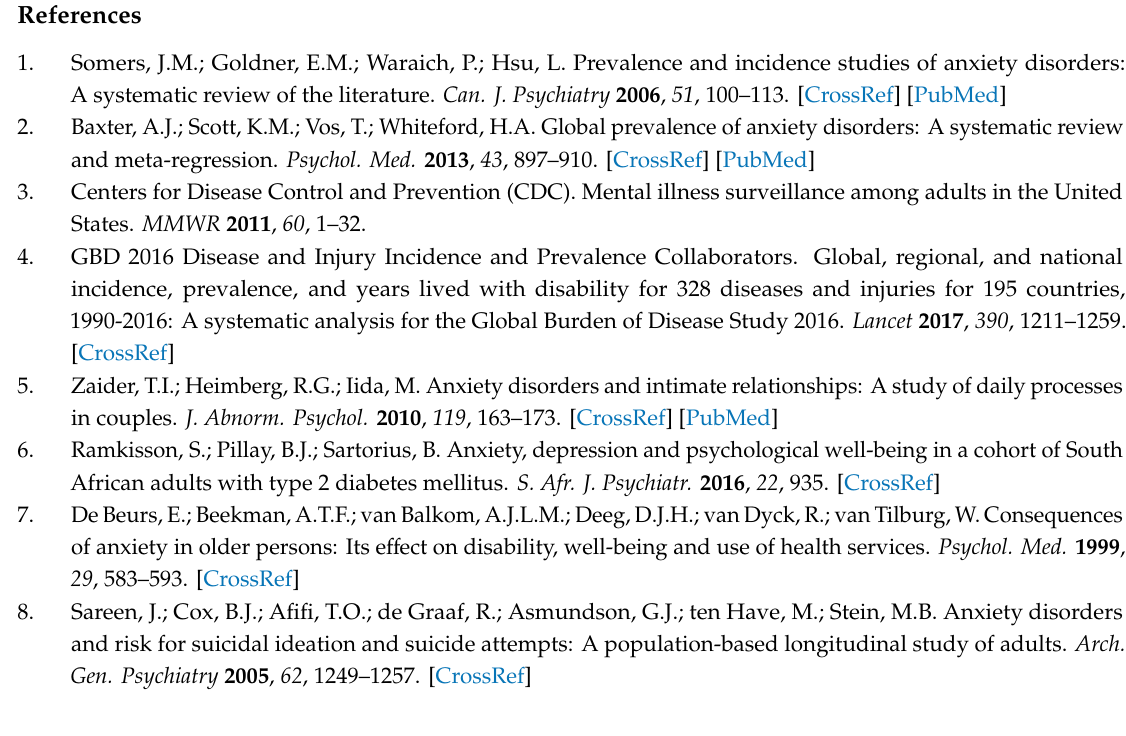
Table S1: Descriptions of